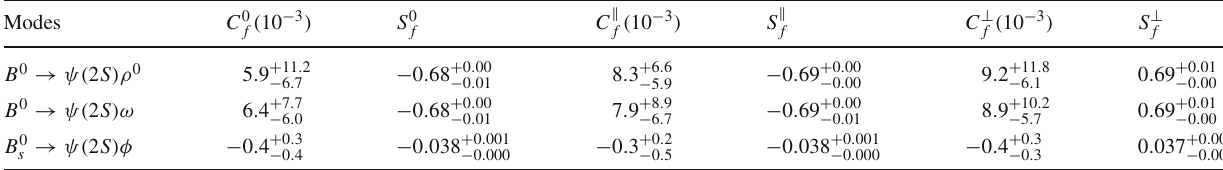
, (cid:5) , ⊥ , (cid:5) , ⊥ and S 0 f f